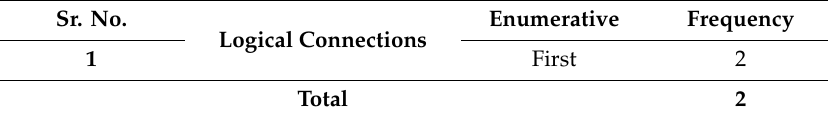
Table 20. Enumerative lexical connections.